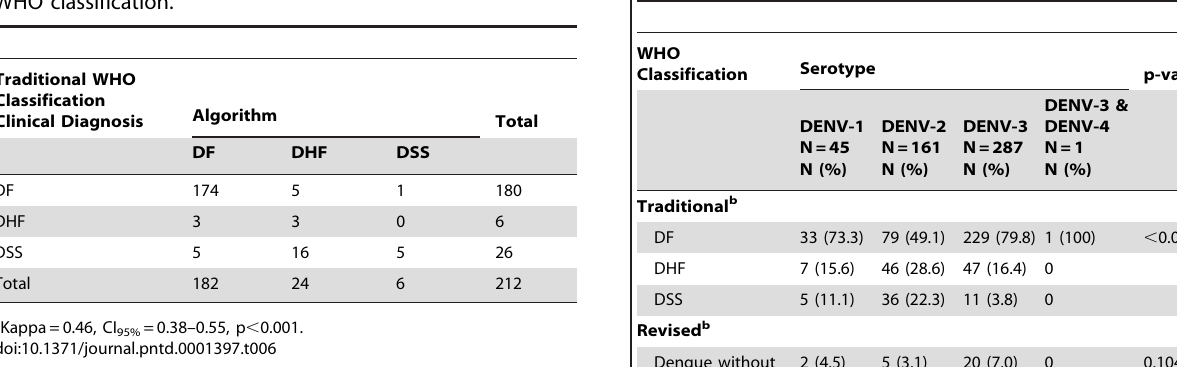
Table 8. Association between traditional and revised WHO classifications for dengue severity and serotype,